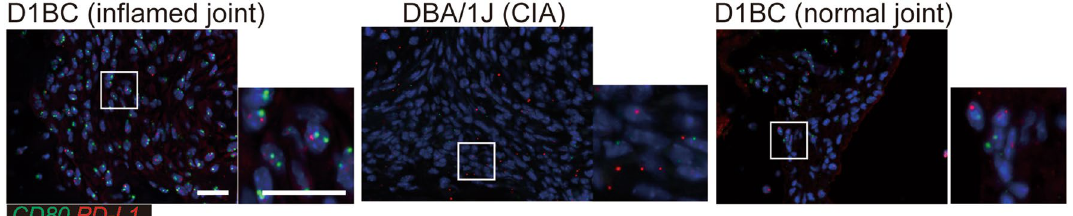
Figure 4. Co-expression of CD80 and PD-L1 in synovial cells. In situ hybridization of CD80 (green) and PD-L1 (red) in D1BC and DBA/1 J mice with chronic inflammatory arthritis and in the control (synovial membrane in D1BC mice without bColII administration). Each right panel shows a magnified image of the square on the left panel. Scale bars indicate 20 μm (white